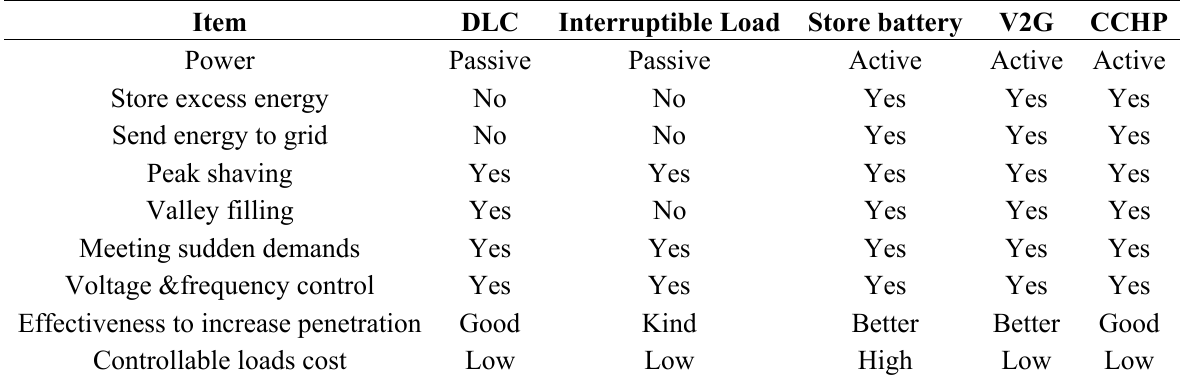
Table 1. Summary of the Controllable